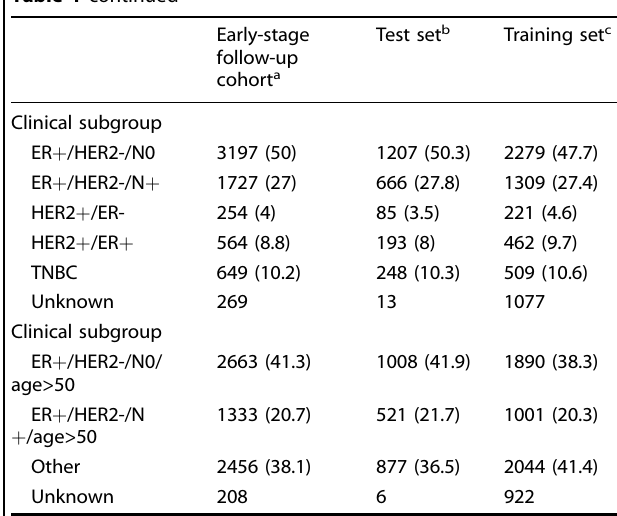
Table 1. Patient and clinical characteristics for SCAN-B study